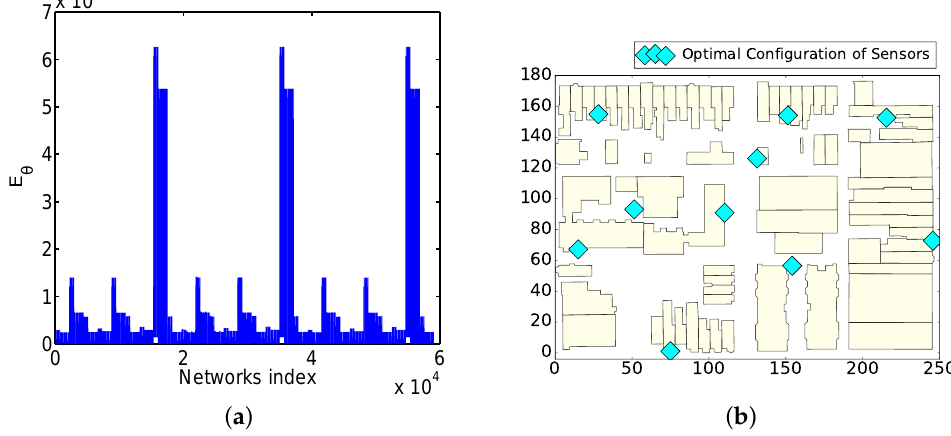
Figure 6. ( a ) Scores Γ ED for all possible networks. The solution of the robust design problem is not unique; ( b ) The optimal network obtained as the solution of the robust design in the average sense